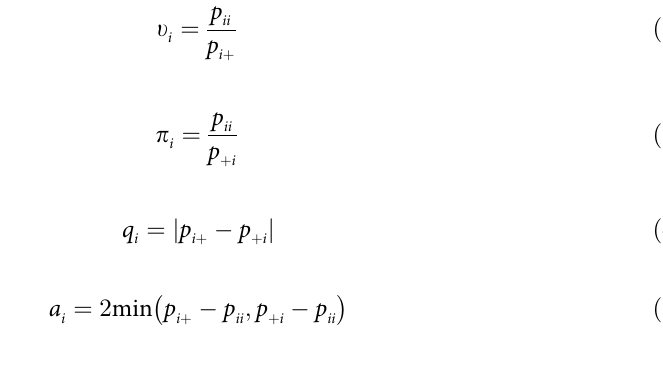
where p is the estimated proportion of the study area that is topsoil texture category i accord- ij ing to the map data and topsoil texture category j according to the field data, where i , j = 1, . . . , is entry n in row i and column j of the sample matrix; n c ; n ij ij the sample matrix; A is the mapped area of category i , and A m , i